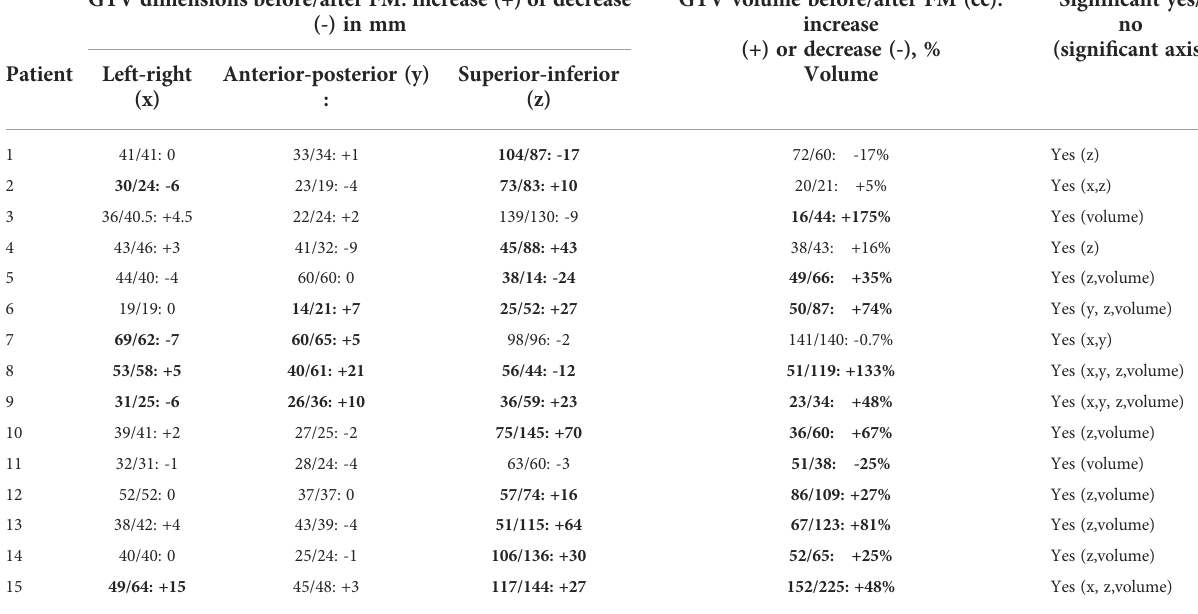
TABLE 1 Gross tumor volume (GTV) modi fi cations before and after fi ducial markers (FM) in the FIDUCOR cohort (n=15). GTV dimensions before/after FM: increase (+) or decrease GTV volume before/after FM (cc): (-) in mm